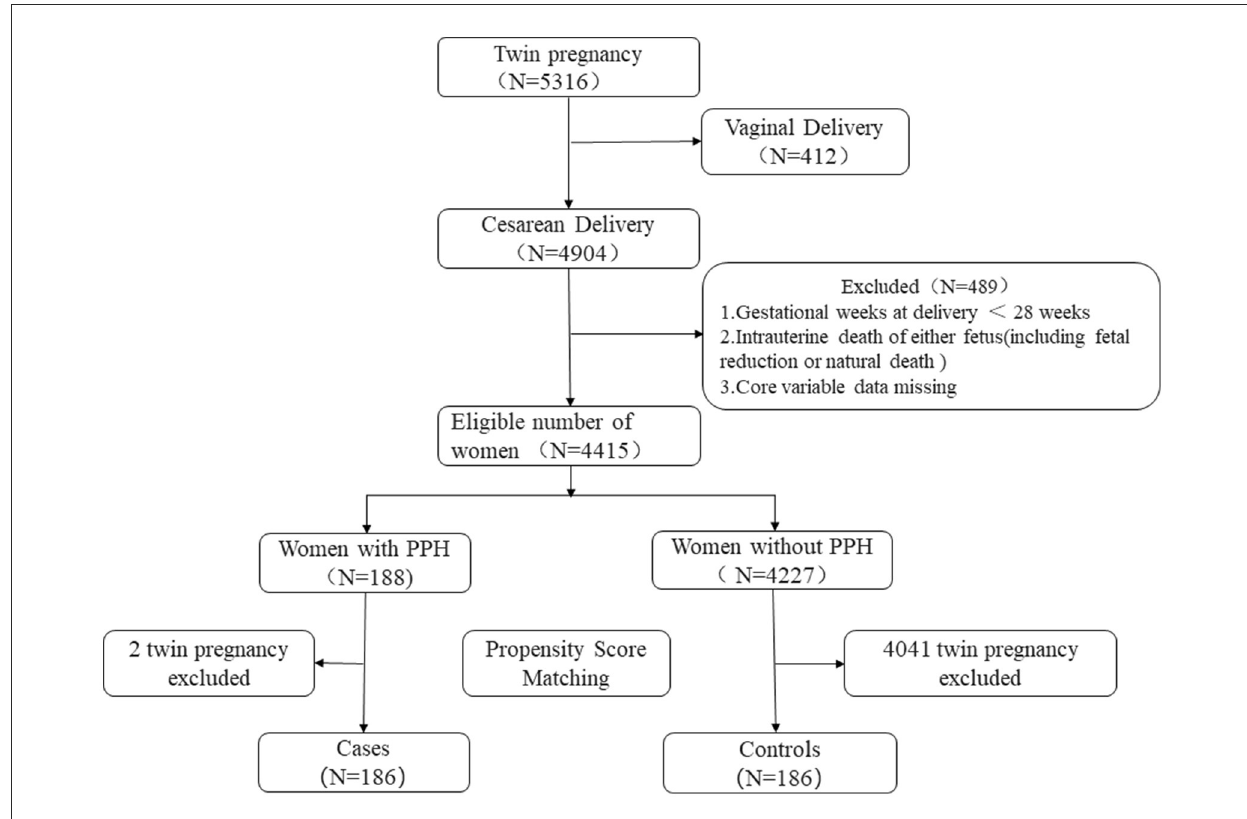
FIGURE1 Study flow